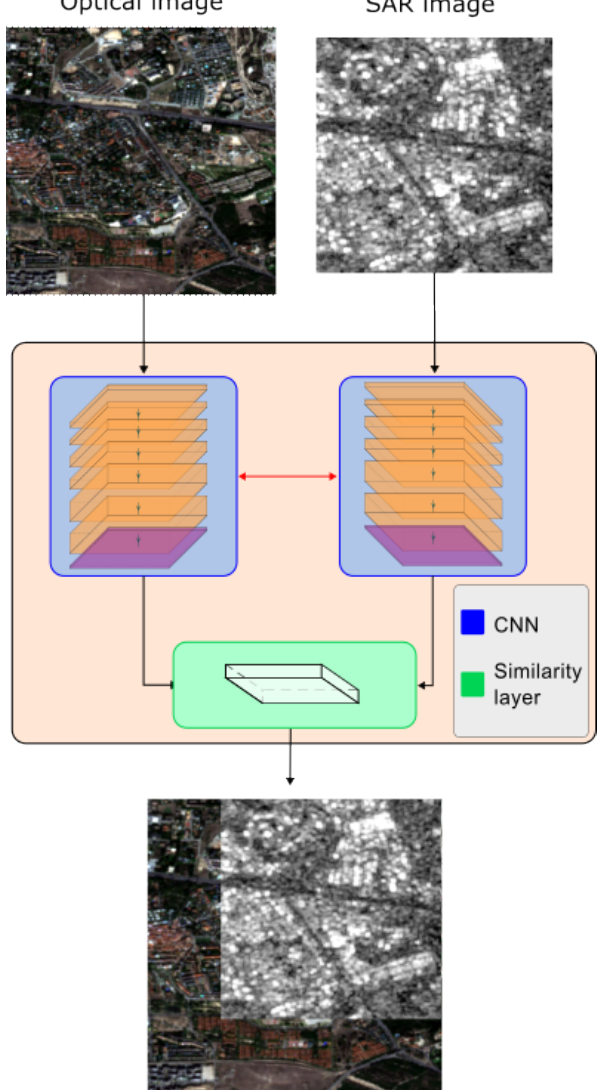
Figure 3. A general Siamese template matches architecture. The red arrow indicates the possible weight-sharing between the two CNN-based feature extractors. Since the CNN translates the images into a homogeneous space, similarity metrics previously demonstrated to be inadequate, such as SSIM and NCC, can now be used to assess the similarity between the CNN feature maps. The satellite images are taken from the SEN1-2